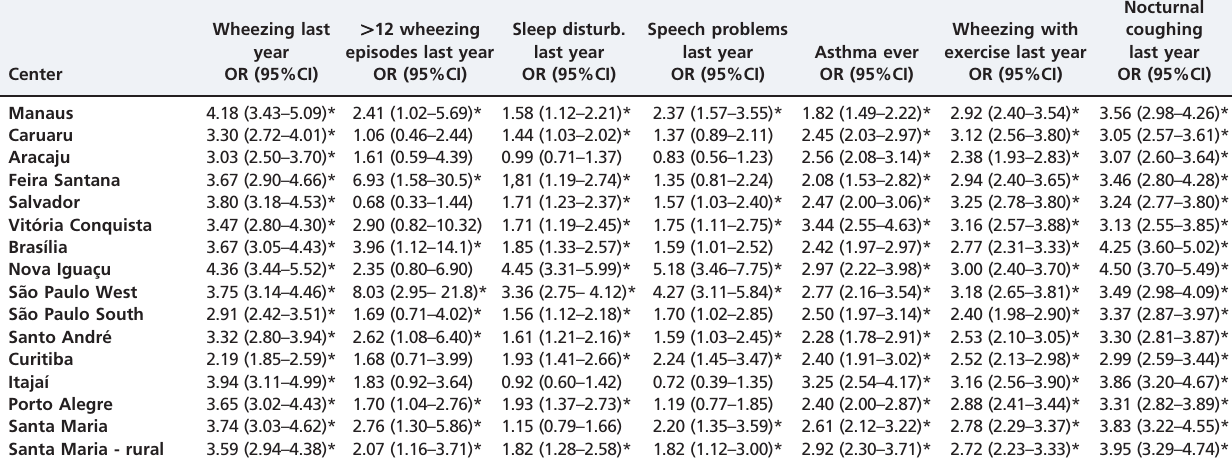
Table 2 - Odds ratio (OR) and 95% confidence interval (95% CI) for wheezing-related symptoms in Brazilian adolescents with current rhinitis from ISAAC Phase Three